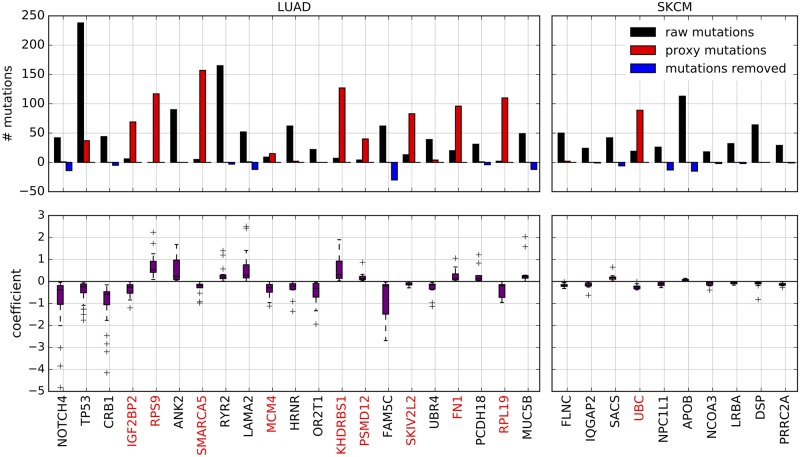
Genes frequently selected in the survival prediction model for LUAD (left) and SKCM (right) learned using the NetNorM representation of mutations with Pathway Commons as gene network.The genes reported are those that were selected at least 10 times in 20 cross-validation folds. For each cancer, genes are ordered from the most frequently selected (left) to the least frequently selected (right). The top panel reports the number of raw mutations in the selected genes (black), as well as the number of “proxy” mutations (red) and the number of mutations removed (blue) after application of NetNorM. The bottom panel reports the coefficients of a gene in the survival SVM model across the cross-validation folds where this gene was selected. Gene names marked in red indicate proxy genes.